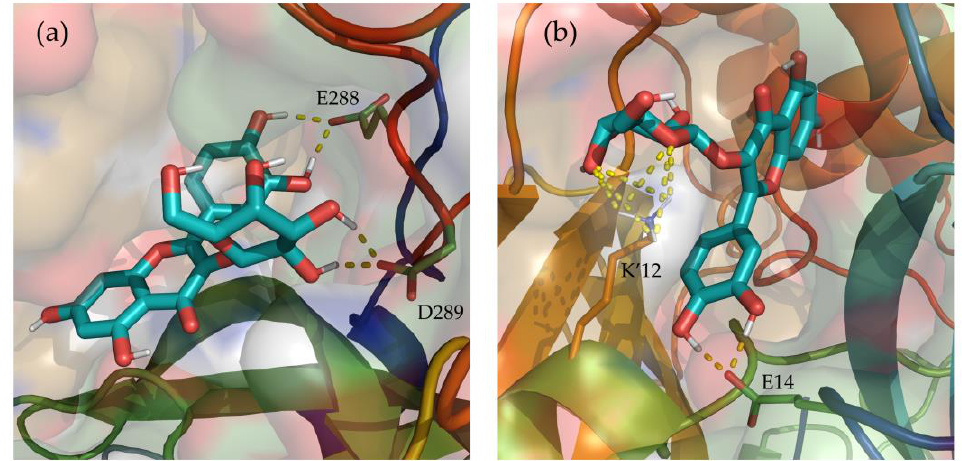
Figure 6. Depiction of the most relevant hydrogen bonds established by Hyperoside, and the two allosteric binding sites identified, for the last 100 ns of their 2 µs molecular dynamic simulations. Representations correspond to the first ( a ) and second ( b ) most stable binding sites identified for Hyperoside. Ligand—M pro hydrogen bonds are represented as a yellow dashed line. The two monomers of the SARS-CoV-2 M pro dimer are depicted in light green (Chain A) and light orange (Chain B). Only the lateral chains of the residues presenting this type of interaction are